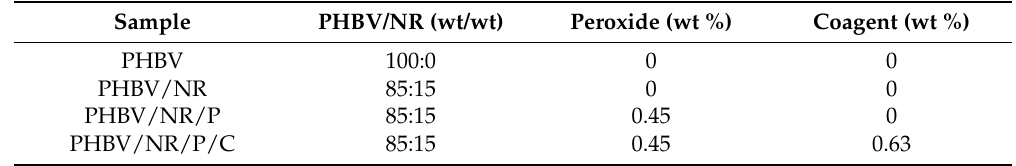
Table 2. PHBV and PHBV/NR blends obtained from extrusion melt